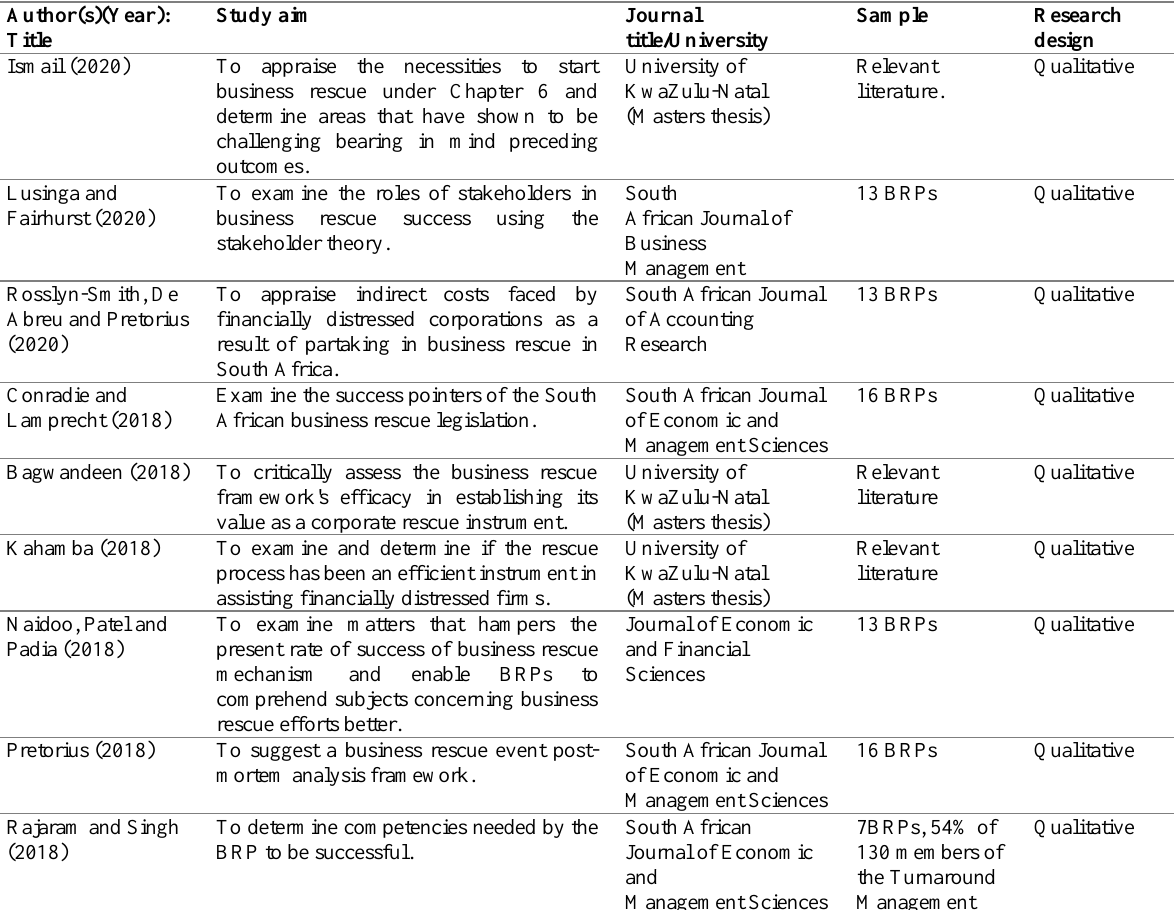
Table 1 : Features of the studies